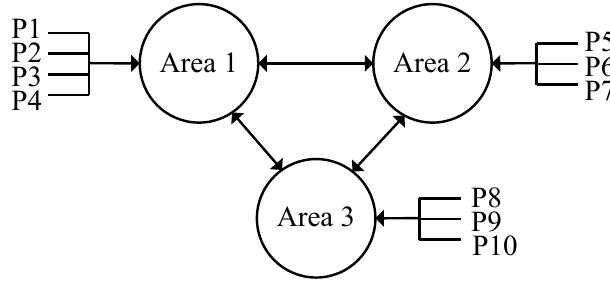
Figure 2. Test system 2, three-area power